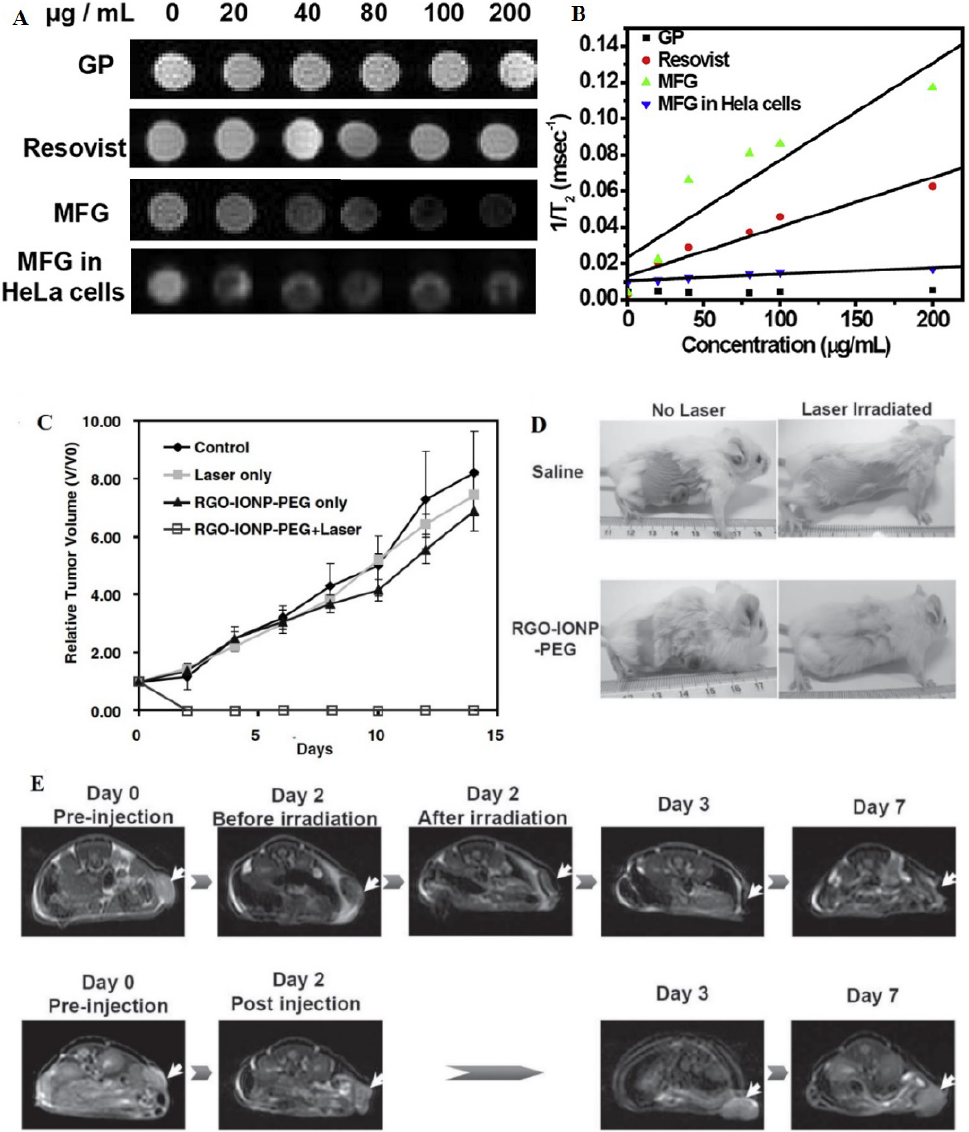
Figure 6. MR images of GNCs in vitro and in vivo imaging guided phototherapy. ( A ) In vitro MRI of MFG and in HeLa cells. The contrast of the images increases with the concentration of MFG and MFG-SiNc 4 than clinically accepted resovist. ( B ) The corresponding 1/T2 intensities with concentration [70]. ( C ) Relative tumor volume with respective to the graphene photodrug and duration of therapy up to 14 days. ( D ) The pictorial representation of mice bearing tumor before and after PT, where the tumor has vanished within a few days of therapy than compared to the control experiments with out RGO-IONPs-PEG and laser. ( E ). Upper row is the MR images of tumor (indicates with white arrow) before and after PT and its suppression monitoring with time (0–7 days). The lower row is for without laser irradiation after injection of RGO-IONPs-PEG [108]. Reprinted/adapted with permission from Ref. [70]. Copy right 2014, copyright Elsevier. Reprinted/adapted with permission from Ref. [108]. Copy right 2012, copyright Wiley-VCH.